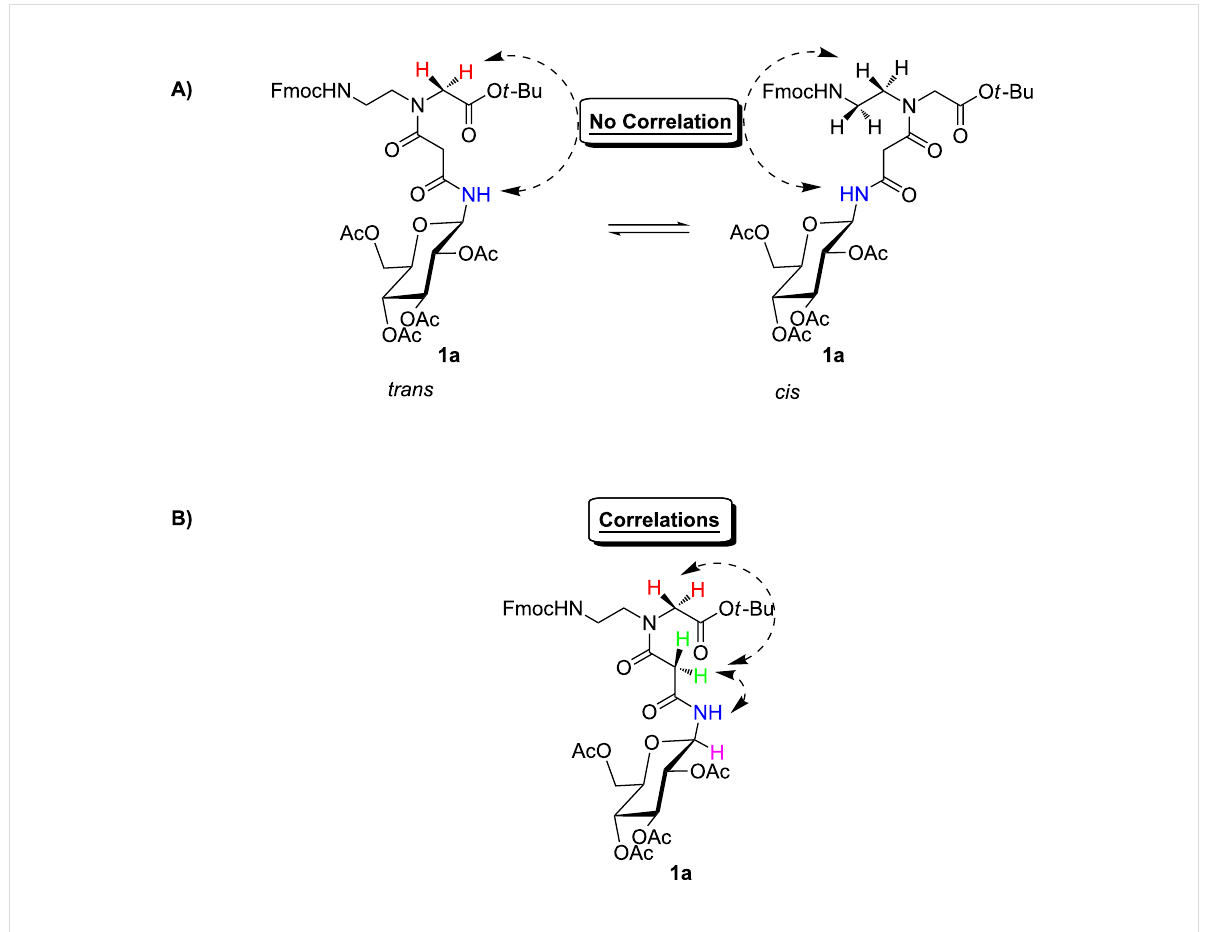
Figure 12: A) Missing correlation between the amidic proton and the methylene or 2-aminoethyl protons of the PNA backbone; B) Observed NOE- correlations of PNA building block 1a .